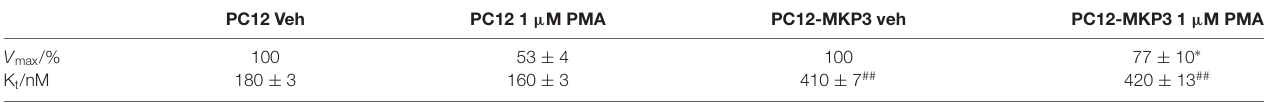
TABLE 1 | Norepinephrine transporter (NET)-specific uptake kinetics in naïve and mitogen-activated protein kinase 3 (MKP3)-expressing PC12 cells following protein kinase C (PKC) activation.